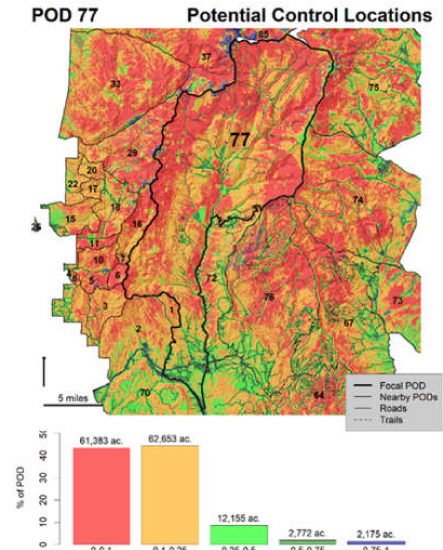
Figure 7. Model-based potential control location (PCL) probability surface for POD 77, with histogram displaying total and percent area in each of five quantitative PCL suitability classes.